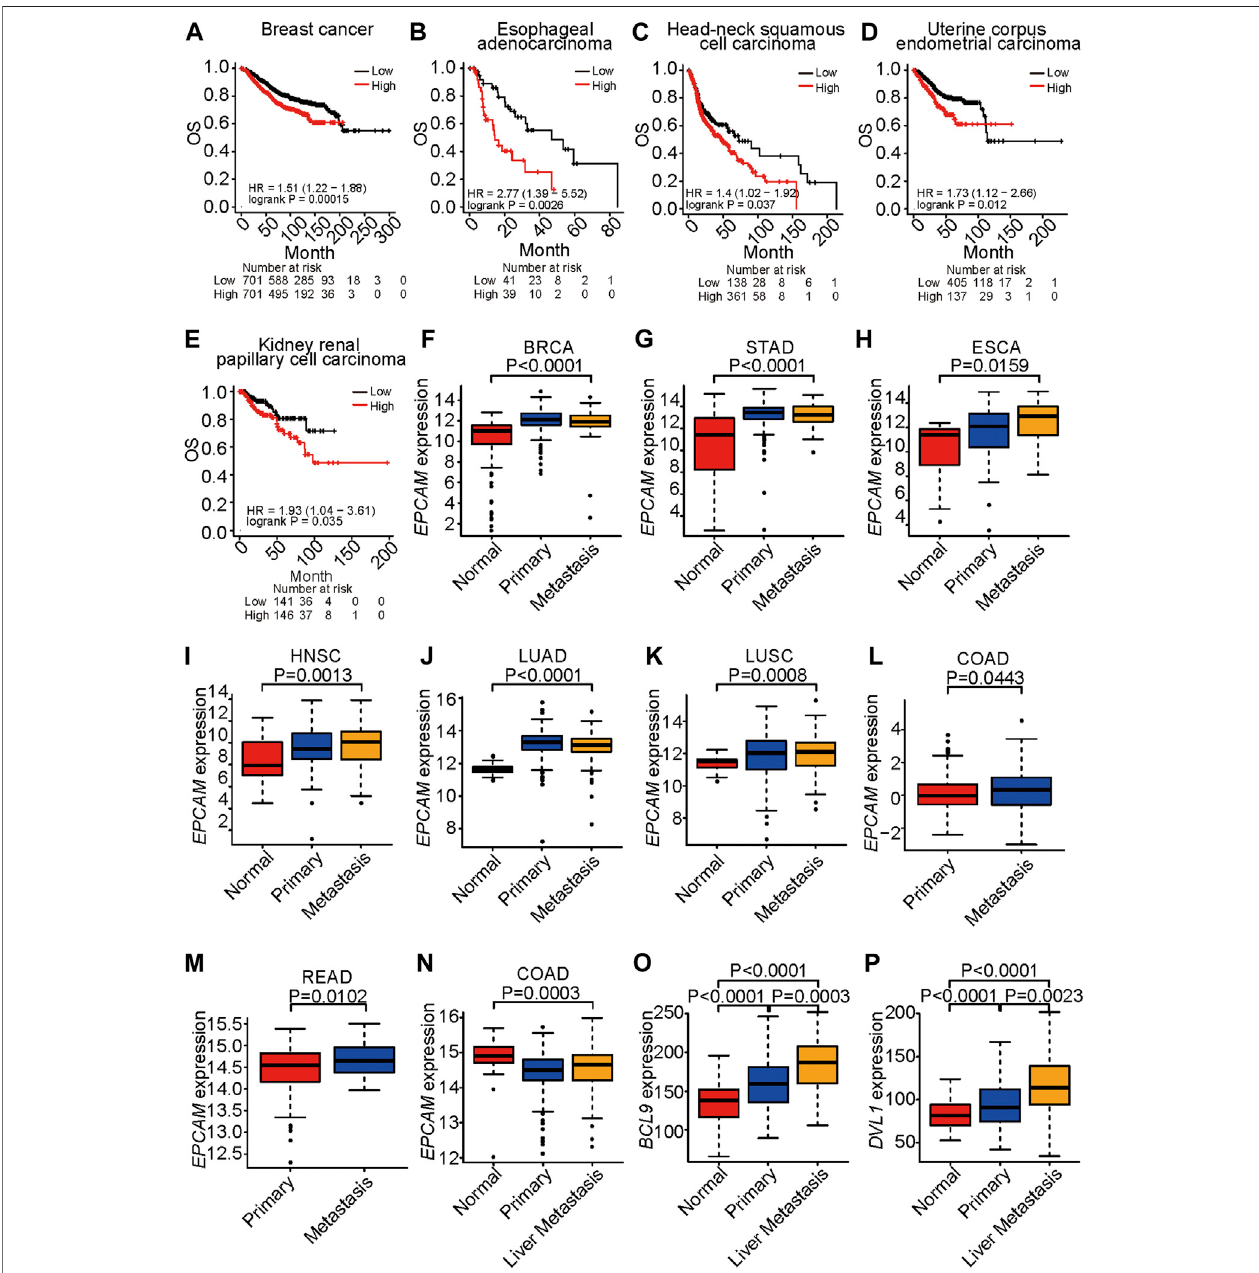
FIGURE 1 | EPCAM expression is correlated to survival and metastasis. (A – E) , Survival analysis of TCGA patients with breast cancer (A) , esophageal adenocarcinoma (B) ,head-neck squamous cellcarcinoma (C) , uterine corpusendometrialcarcinoma (D) and kidneyrenal papillary cell carcinoma (E) ,respectively. OS represents overall survival. Classi fi cation is according to expression level of EPCAM . (F – K) , EPCAM expression level in normal, primary and metastatic tissue in BRCA (F) , STAD (G) , ESCA (H) , HNSC (I) , LUAD (J) , LUSC (K) , respectively. EPCAM expression level in primary and metastatic tissue in COAD (L) , READ (M) . (N – P) , EpCAM (N) , BCL9 (O) , DVL1 (P) expression level, respectively, in normal, primary and liver metastatic tissue in colorectal